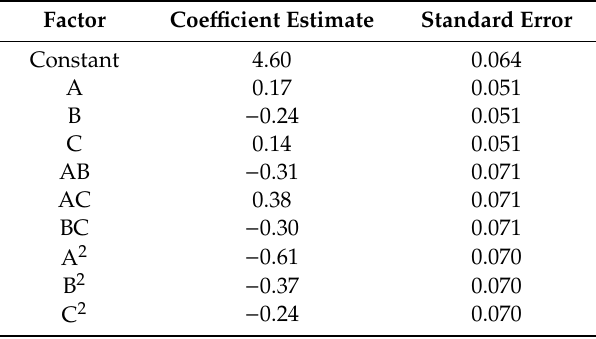
Table 4. Regression coe ffi cients estimate of the predicted quadratic polynomial